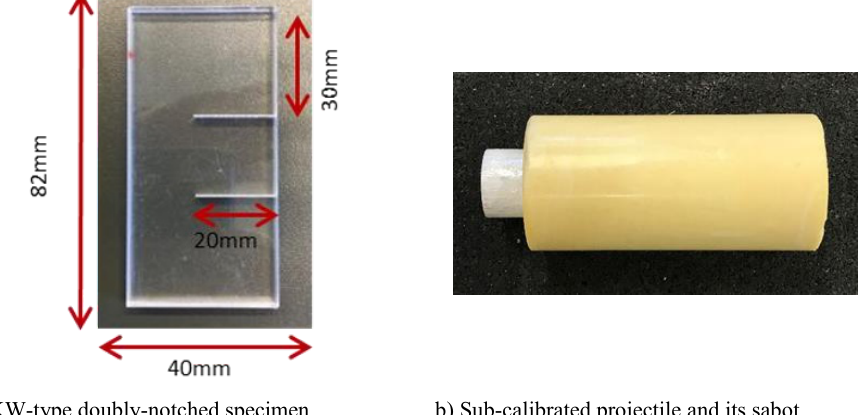
Fig. 1. KW-type specimen and projectile used for the KW-type impact tests. After